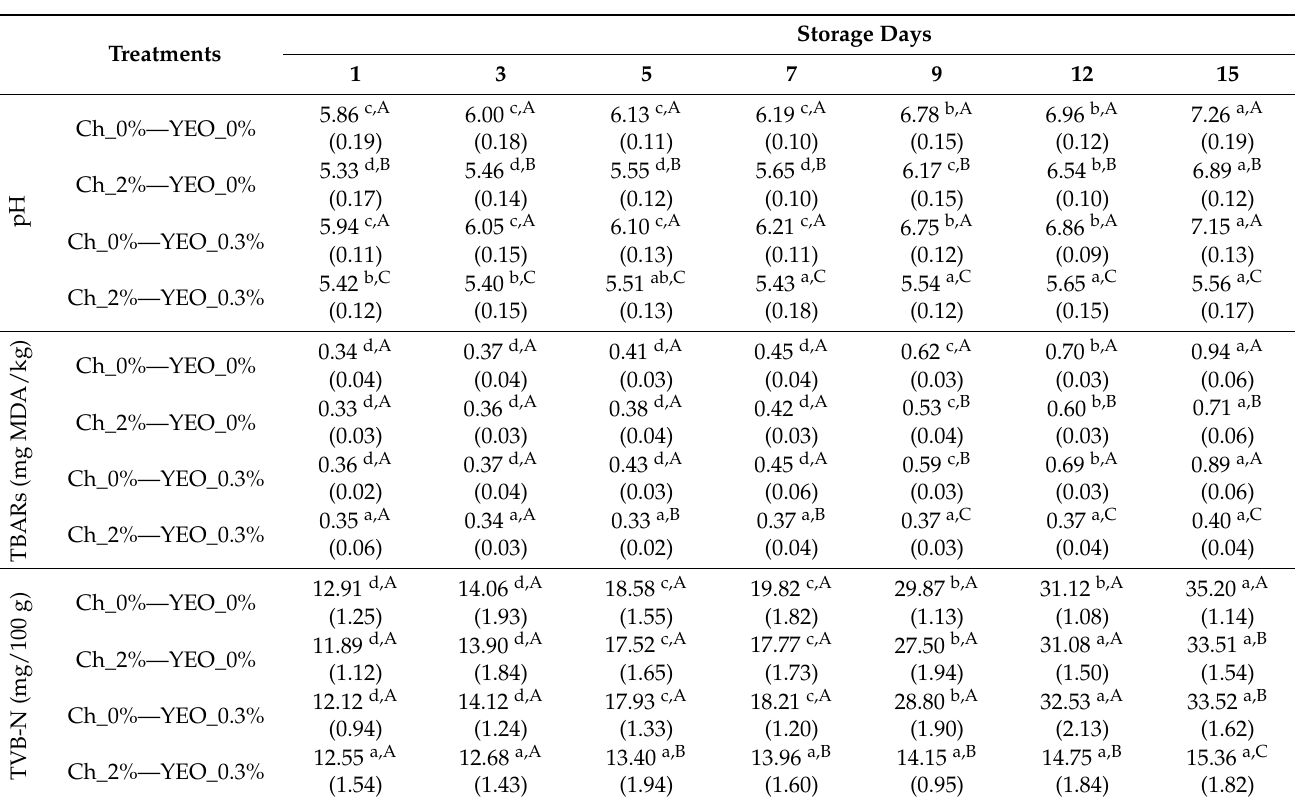
Table 3. Changes in pH, thiobarbituric acid reactive substances (TBARs), total volatile basic nitrogen (TVB-N) and pH values of different coating treatments of chicken breast fillets during different storage days at 4 ◦